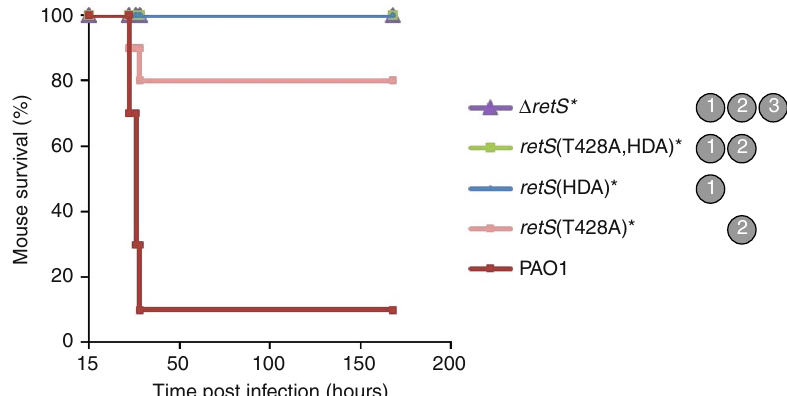
Fig. 5 Mechanisms 1 and 2 are important for virulence in mice. Survival of mice infected intranasally with the retS mutant strains. Mice infected with the wild-type PAO1 strain developed an acute respiratory infection. Two independent experiments were performed, each with fi ve mice per mutant strain (ten mice per mutant strain). The inoculum was 2 × 10 7 CFUs per mouse. *Indicates strains showing signi fi cantly attenuated virulence compared to PAO1 ( P < 0.01, Mantel-Cox Log Rank with Bonferroni ’ s correction for multiple comparisons). The mechanisms absent from each strain are indicated in